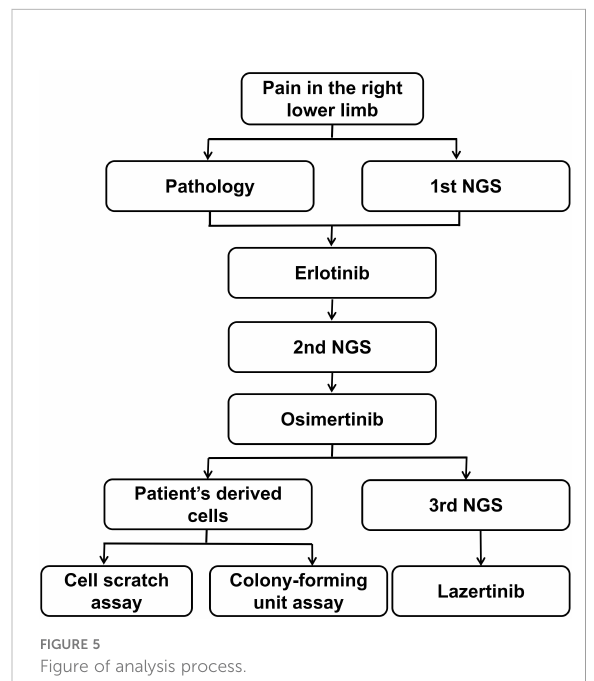
FIGURE 5 Figure of analysis